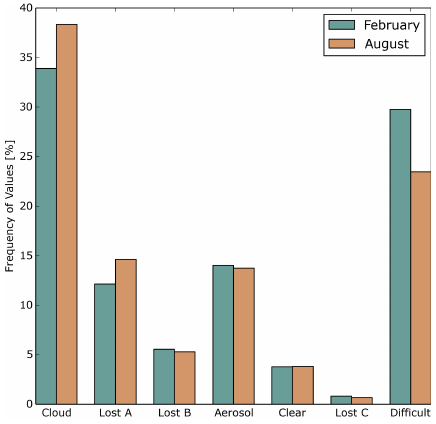
Figure 7. Frequency of value assignment to each class for each month.